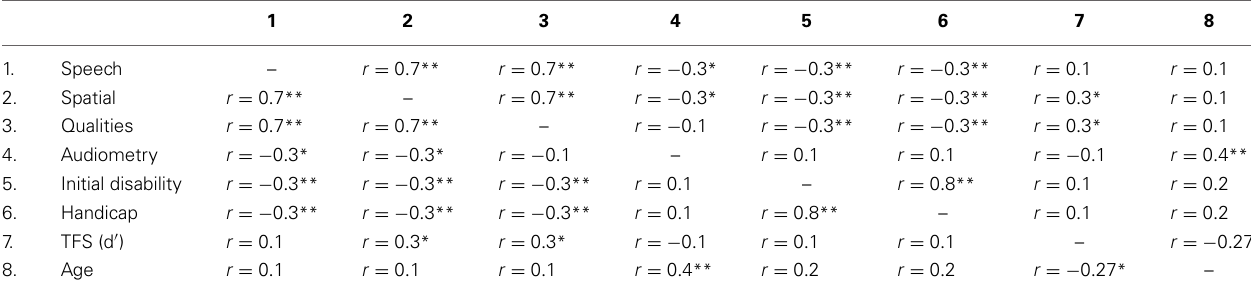
Table 2 | Results of pearson correlation for pre-fitting assessment SSQ-A and TFS.